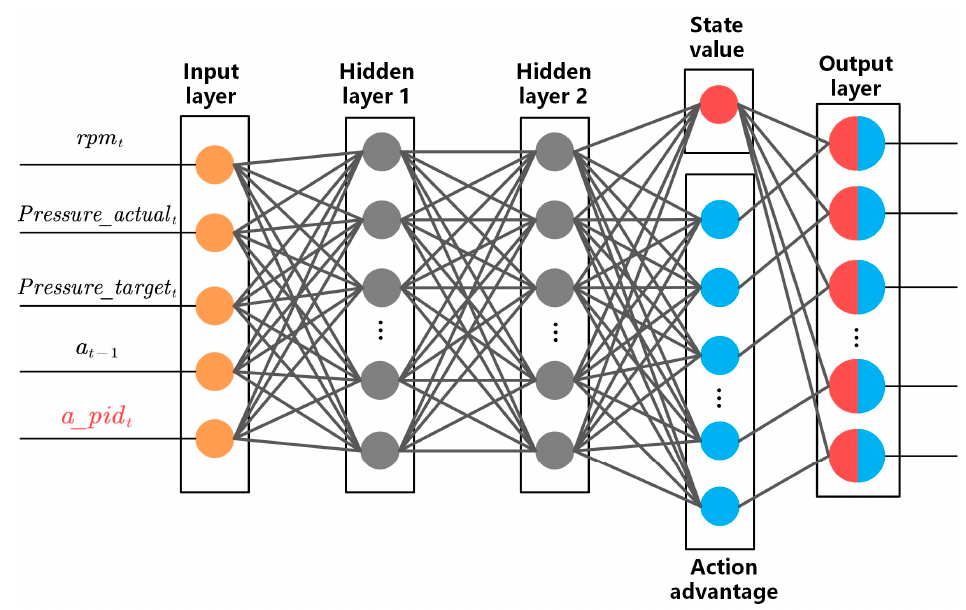
Figure 6. Illustration of the dueling Q-network. Table 1. Dueling DQN